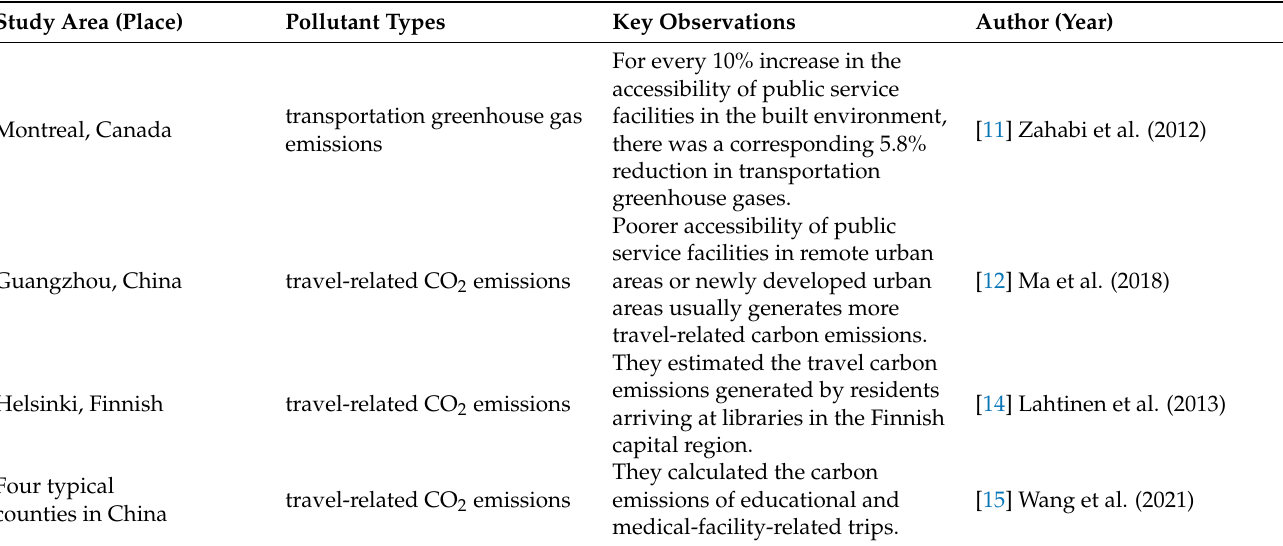
Table 1. The summary of researches on the relationship between the LPSF and travel carbon emis-